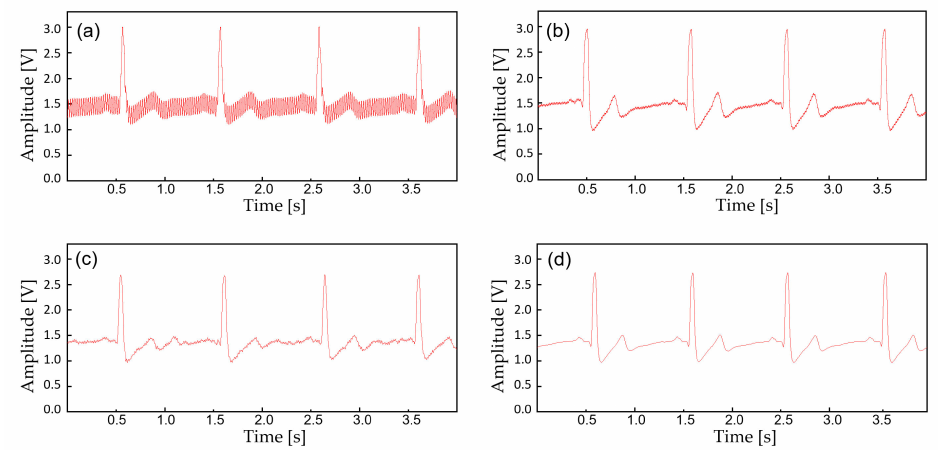
Figure 7. The biopotential signals with additional filtering. ( a ) Raw ECG acquired from the AFE at 30 cm away from the wall power; ( b ) ECG filtered with an analog notch filter (twin-T); ( c ) ECF filtered with an IIR digital filter; ( d ) ECG filtered with ( b , c